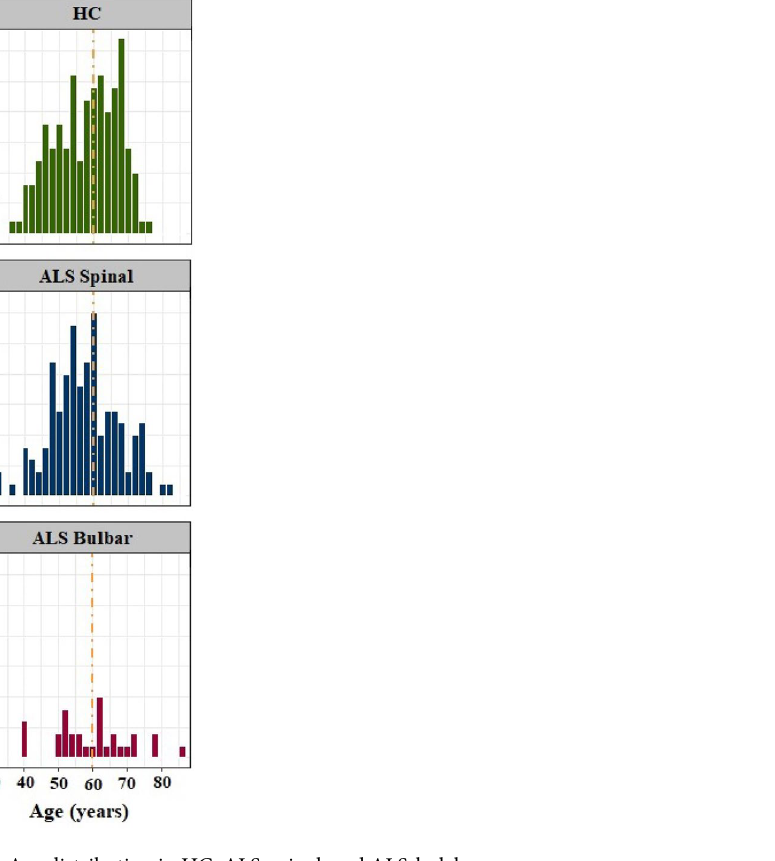
Figure 1. Age distribution in HC, ALS-spinal, and ALS-bulabar